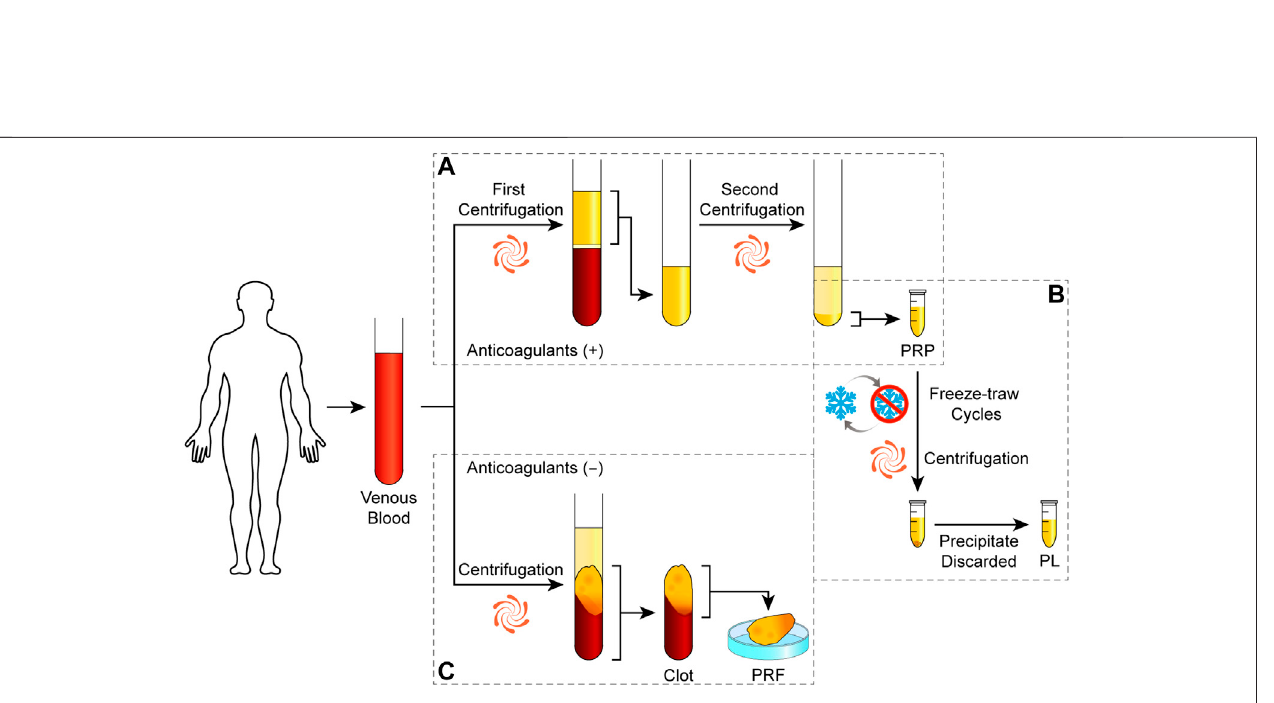
Frontiers in Bioengineering and Biotechnology |